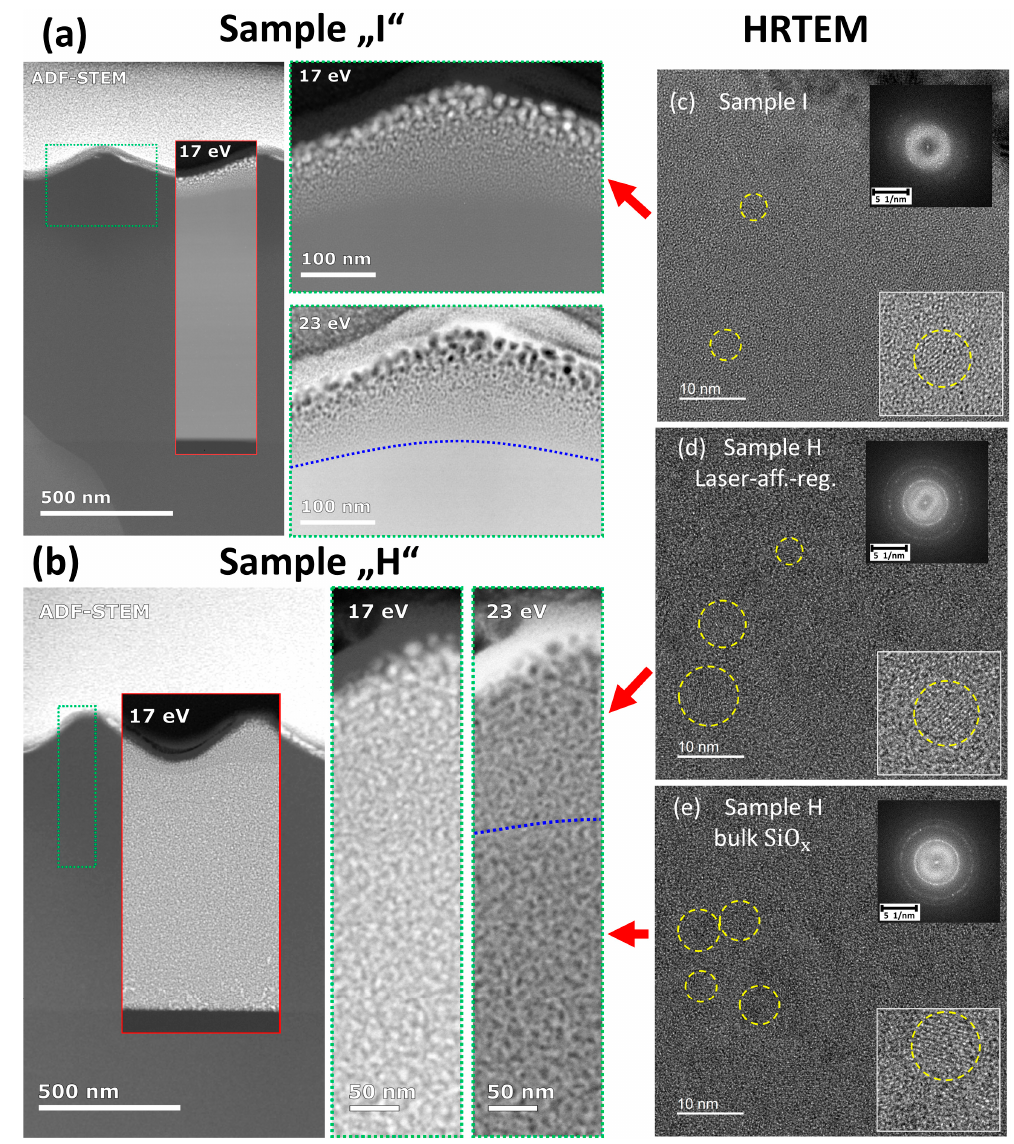
Figure 7. Selected results of the TEM/STEM analysis. ( a ) ADF-STEM overview of sample “I”, laser-structured with a period of 600 nm and a peak height of 80 nm. The sample is coated with a polycrystalline/amorphous Pt-C layer for the FIB preparation. Inset on the left shows the EELS fit amplitude map of the 17 eV plasmon peak, with higher intensity corresponding to regions containing more silicon rich clusters. Enlarged panels in the middle correspond to higher-resolution STEM-EELS results for a region indicated by the dashed rectangle in the ADF image. The 17 eV fit amplitude map shows the presence of large silicon clusters at the surface, with gradually decreasing cluster size following the surface topography, and roughly corresponding to the thermal diffusion length of 20 ns laser pulses in SiO x . The 23 eV fit amplitude map correlates with the amorphous SiO x content within the sample; consequently, creating a roughly contrast-inverted image of the 17 eV